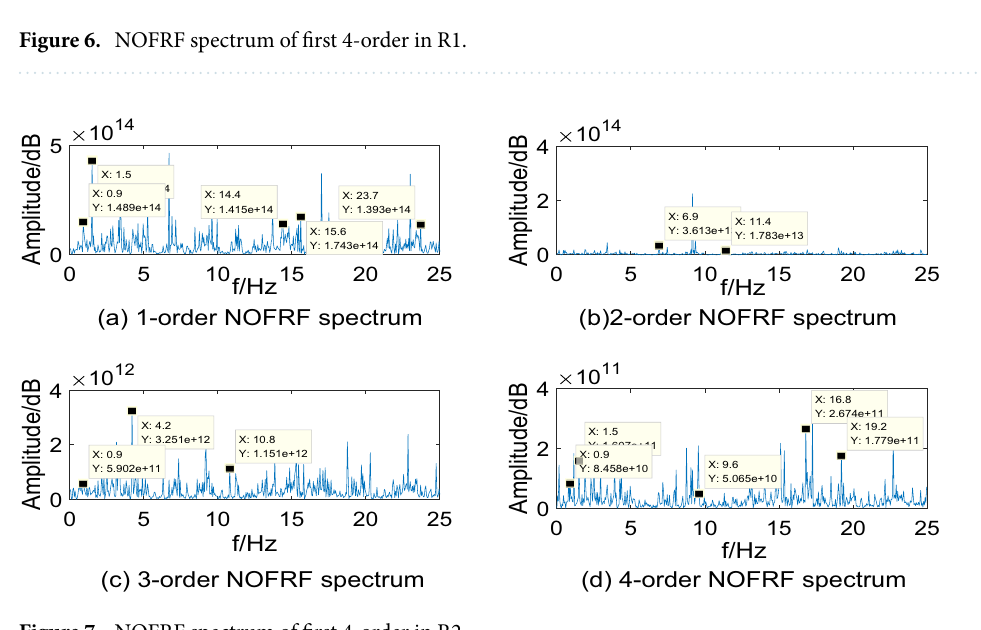
Figure 7. NOFRF spectrum of first 4-order in